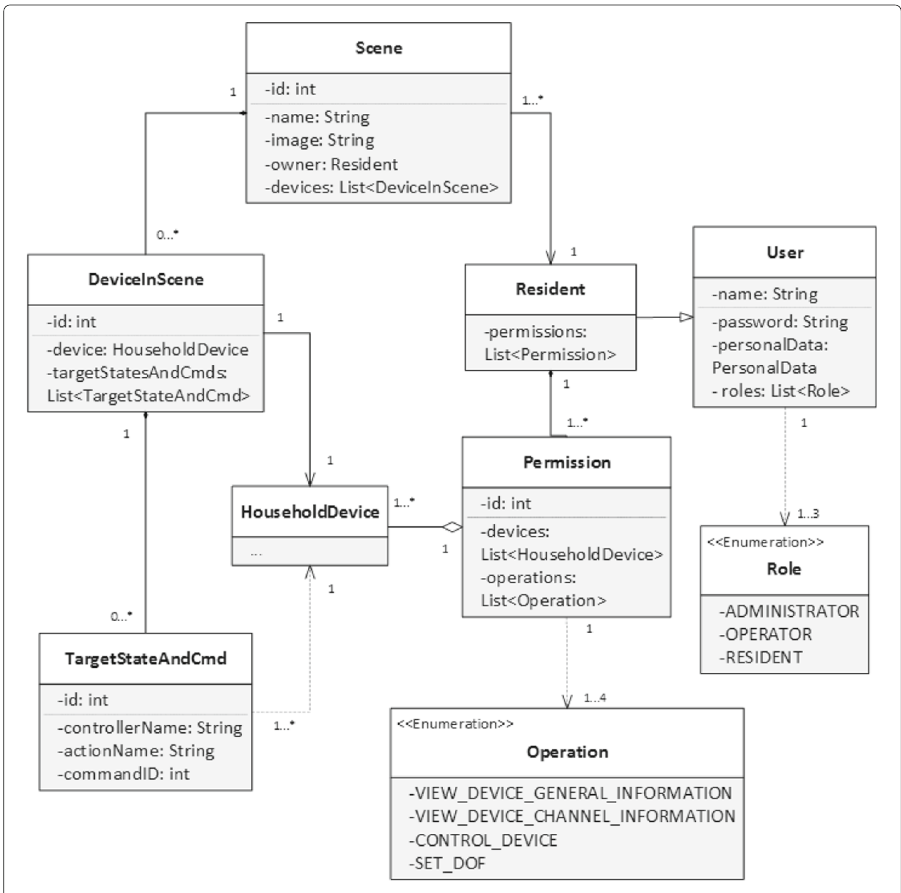
Fig. 6 The UML class diagram of the scene